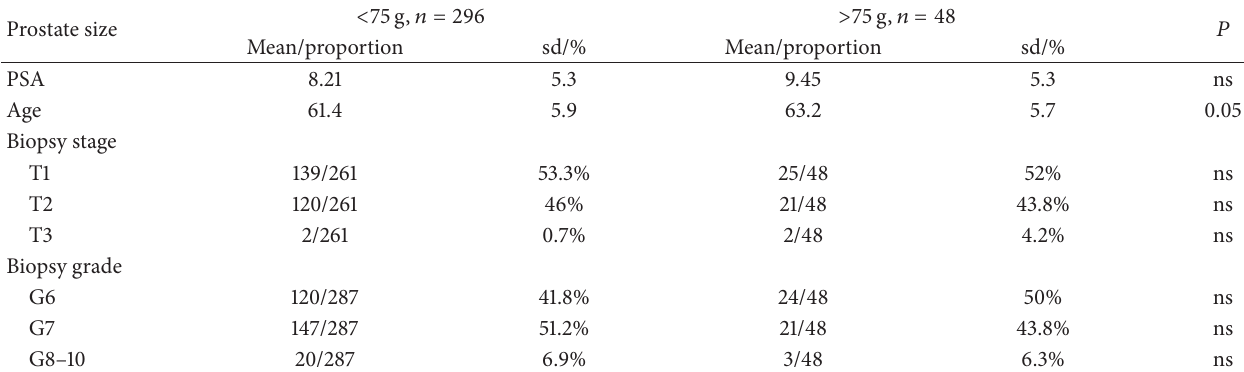
Table 1: Preoperative